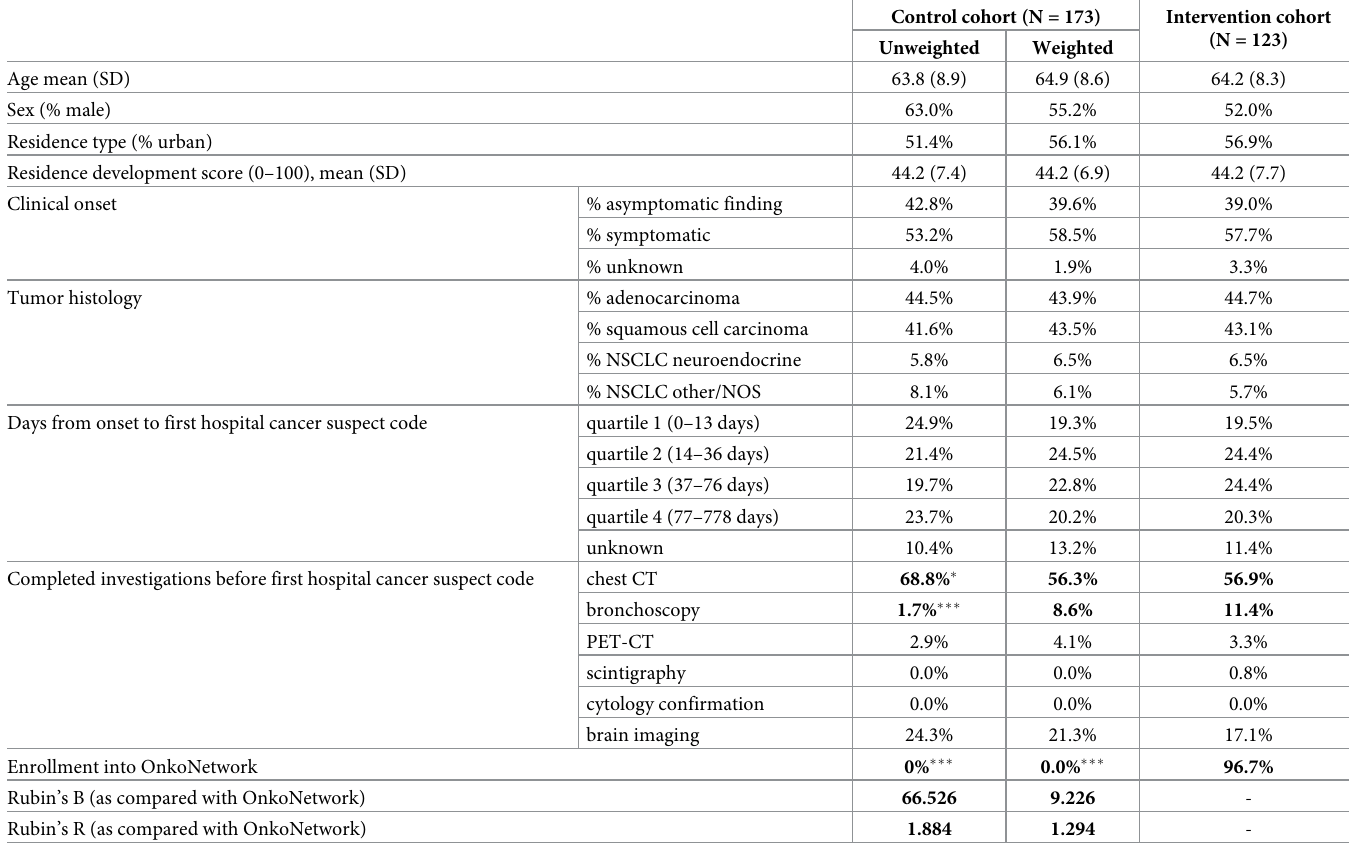
Table 1. Baseline characteristics of the study population. Control and intervention cohorts refer to 12-month patient samples before and after OnkoNetwork imple- mentation, respectively. For the Intervention cohort, unweighted and weighted data are